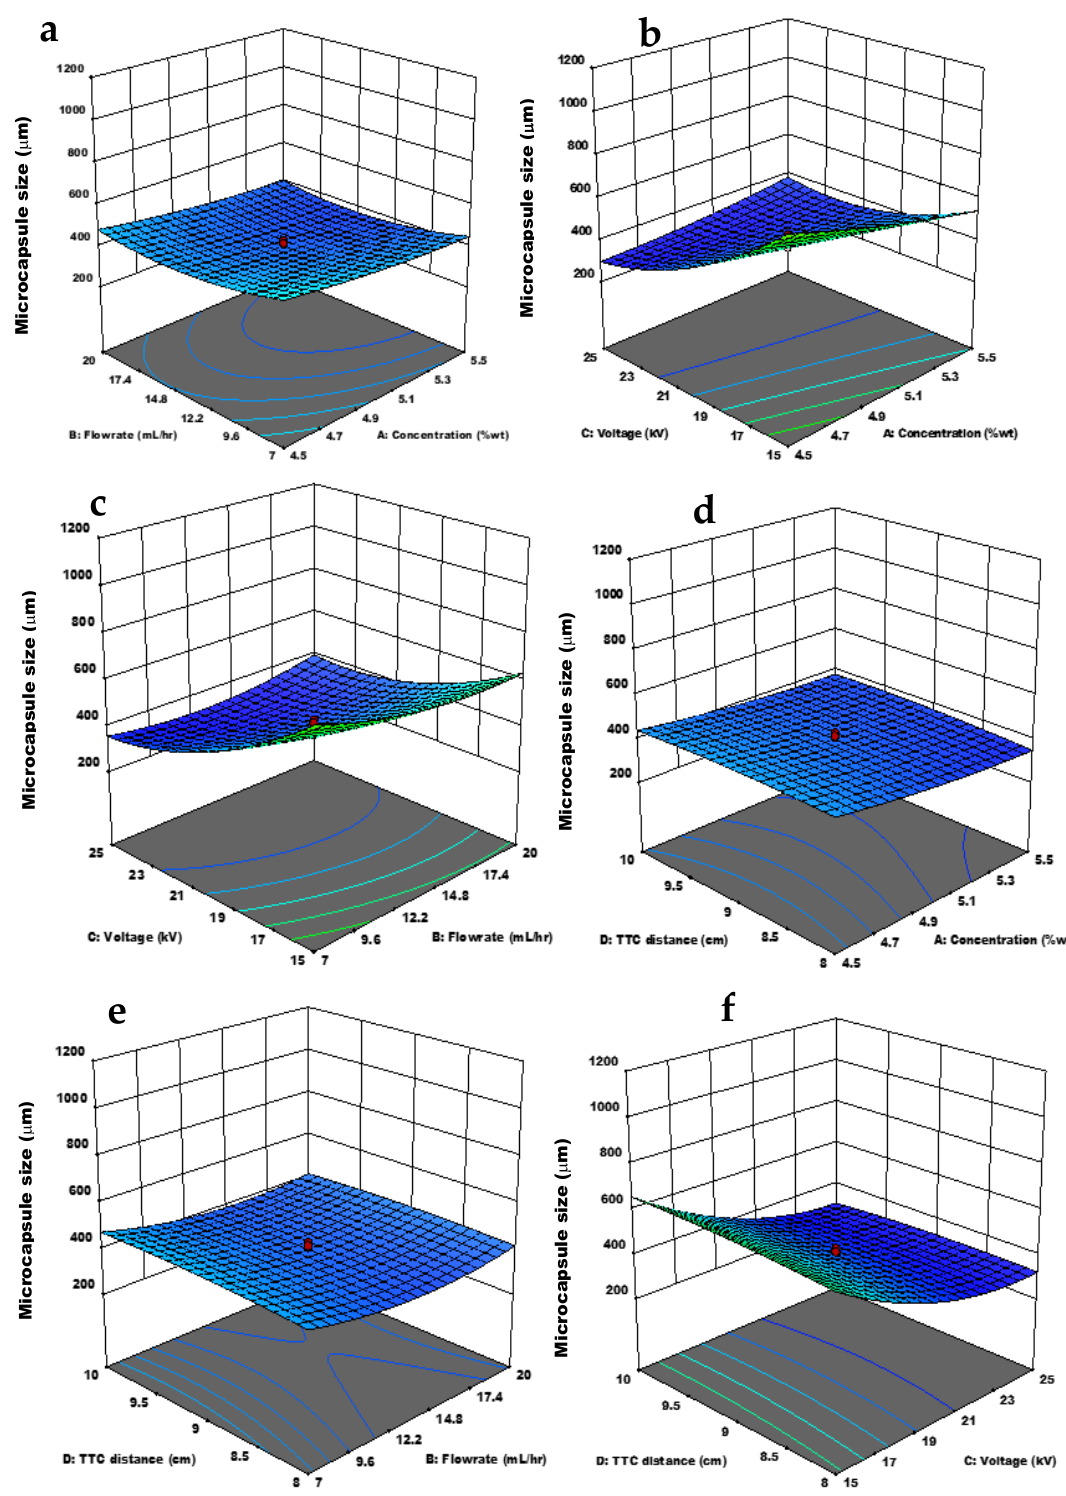
Figure 2. Response surface plot of the interaction effect of independent variables on microcapsule size: ( a ) Flow rate and concentration; ( b ) Voltage and concentration, ( c ) Voltage and flow rate; ( d ) TTC distance and concentration; ( e ) TTC distance and flow rate; ( f ) TTC distance and voltage.